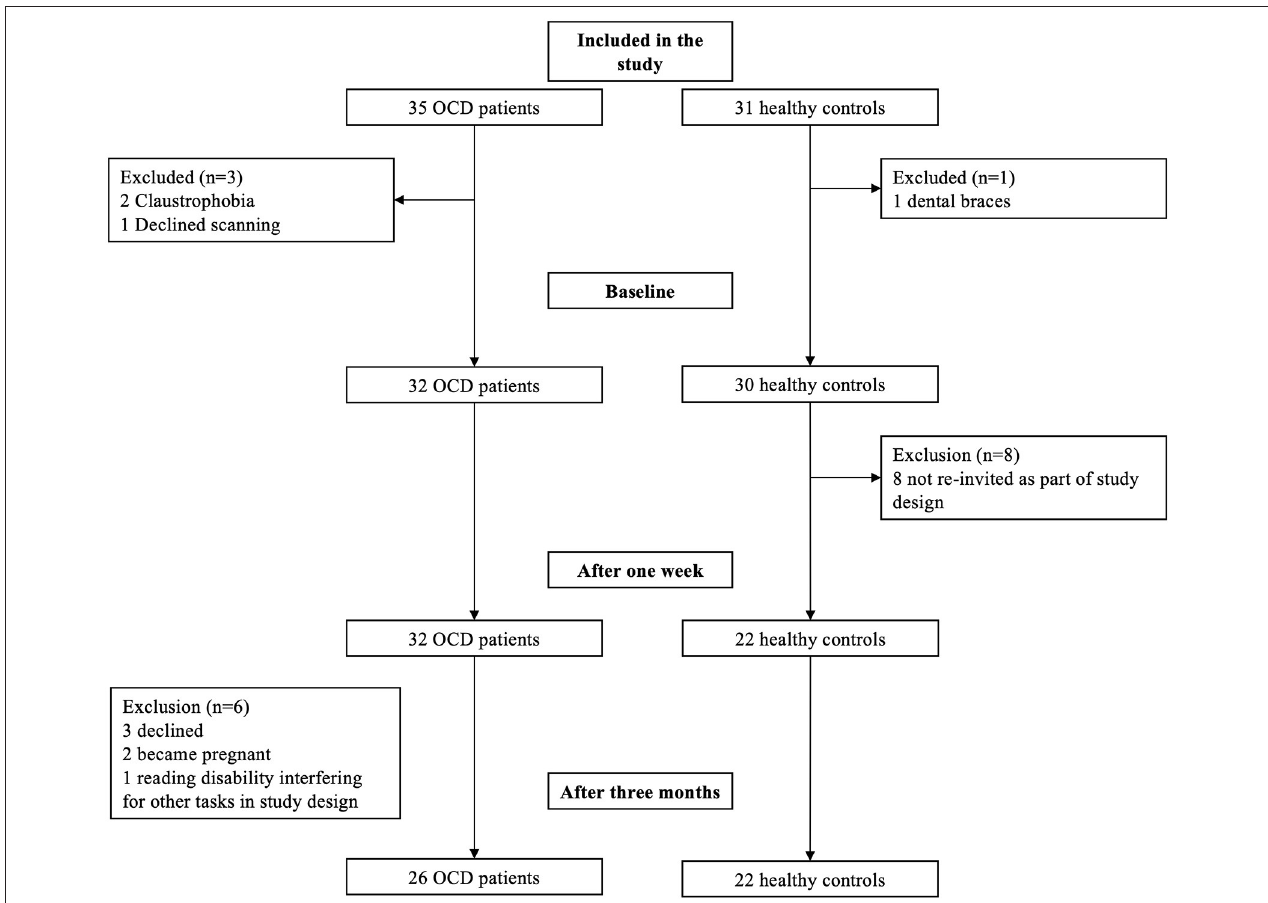
FIGURE 1 | Flowchart of participation over the timespan of the study. This includes from pre-study exclusion to baseline, 1 week after treatment, dropouts, and 3 months after treatment